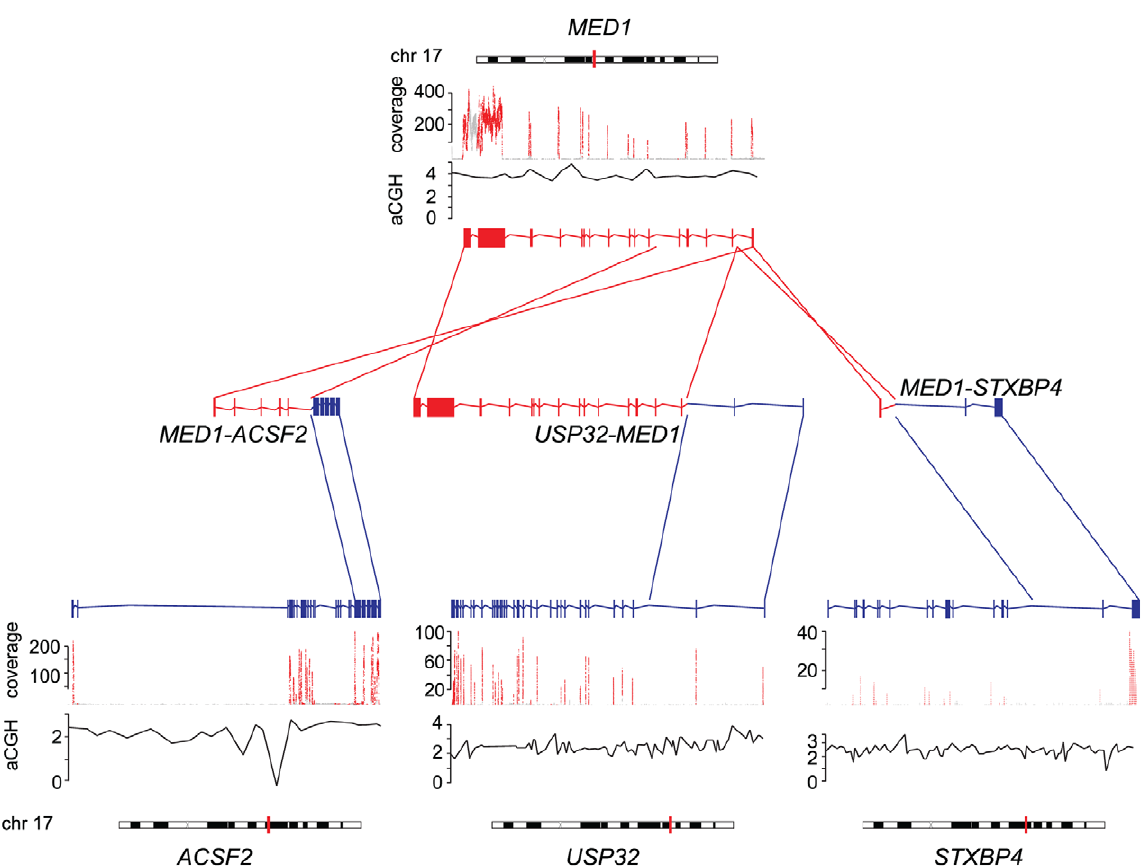
Figure 3. MED1 forms fusions with several partner genes. Exonic expression of MED1 and its partner genes ACSF2 , USP32 and STXBP4 is indicated by sequencing coverage (red). Copy number changes measured by aCGH (black lines) in reference to normal copy number (horizontal gray lines), and chromosomal positions (vertical red lines on chromosomes) are indicated. Transcript structures of wild type genes as well as gene fusions are indicated by red ( MED1 ) and blue ( ACSF2, USP32, STXBP4 ), and connected with lines of same color. Arrows show the 5 9 3 9 direction of the genes.